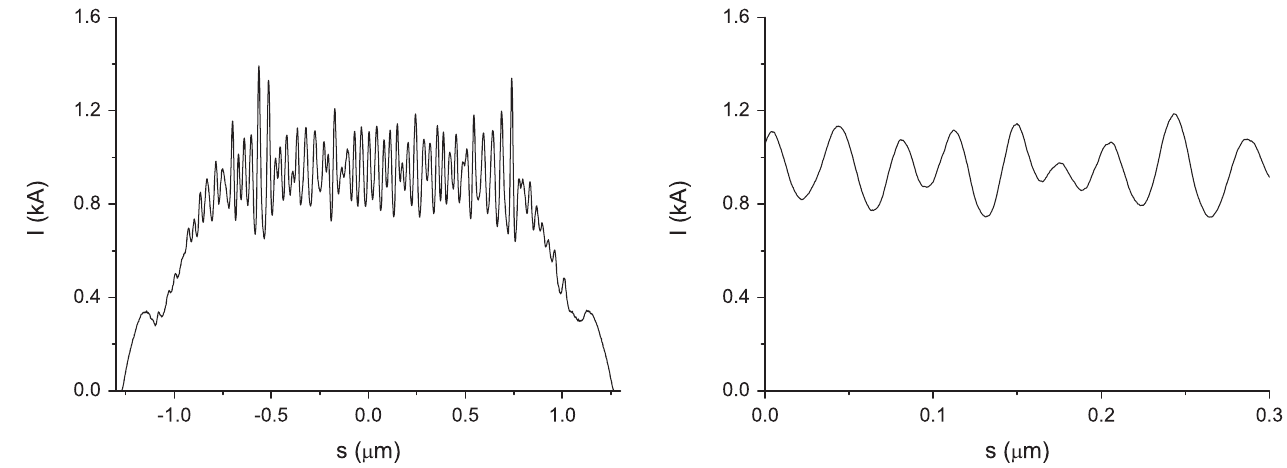
FIG. 4. Modulated electron bunch (left) and its enlarged fraction (right) after the third amplification cascade. The calculations were performed with ASTRA .